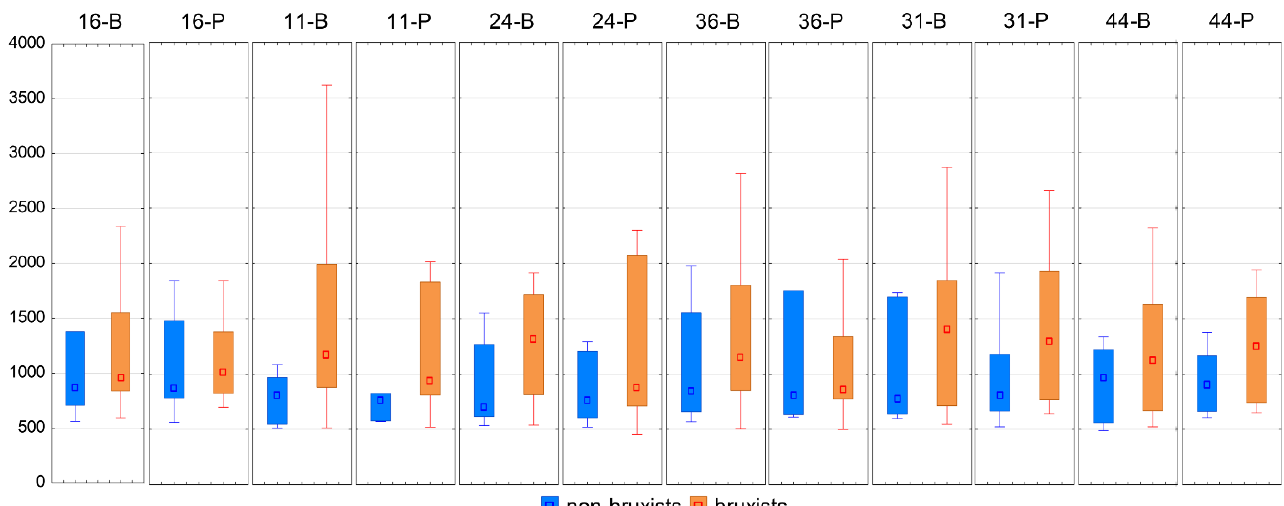
Figure 2. A comparison of gingival crevicular fluid volume in bruxists and non-bruxists — Median, Q1–Q3, Min–Max (B, buccal/labial; P, palatal/lingual).